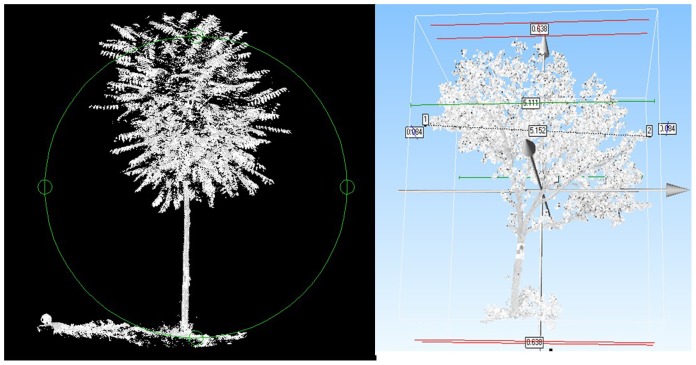
3D point cloud data.